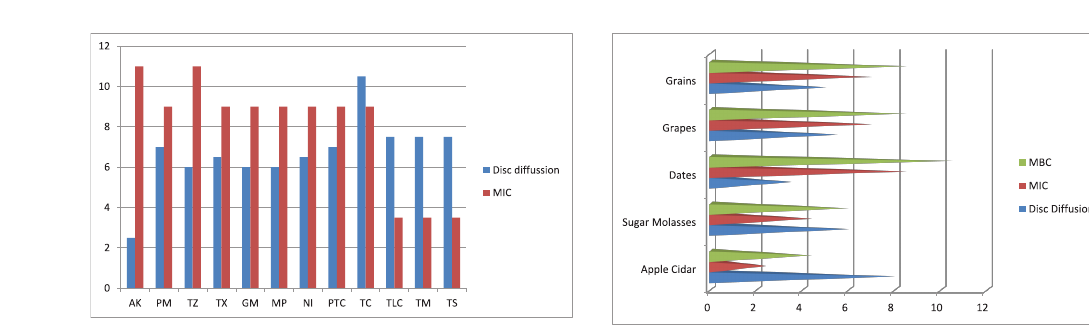
Fig. 2. Comparison of mean conventional susceptibility Fig. 1. Comparison of mean e-test susceptibility of 10 of 10 clinical Pseudomonas aeruginosa isolates to clinical Pseudomonas aeruginosa isolates to standard organic ethanoic acids derived from different sources. synthetic chemical antibiotics Table 5. Comparison of minimum inhibitory concentrations of organic ethanoic acids among Pseudomonas aeruginosa isolates determined by conventional assays. Organic ethanoic acids (µg/mL) Sample Apple cider Sugar molasses Dates Grapes